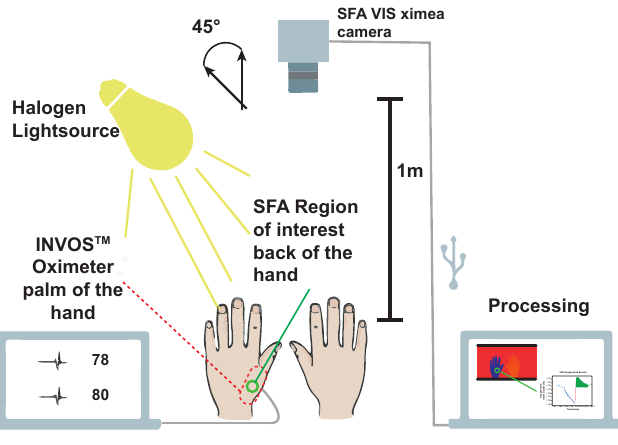
Figure 9. Experimental setup. XIMEA [46] camera 1m above volunteers hands. 45 ◦ (following the CIE recommendation [62] and ([45] p. 144)) between halogen lightsource and SFA camera. Parallel measurement at the palm of the hand with the INVOS. SFA measures at the back of the hand with green circle indicating region of interest for averaging. External processing on a computer (adapted from Reference